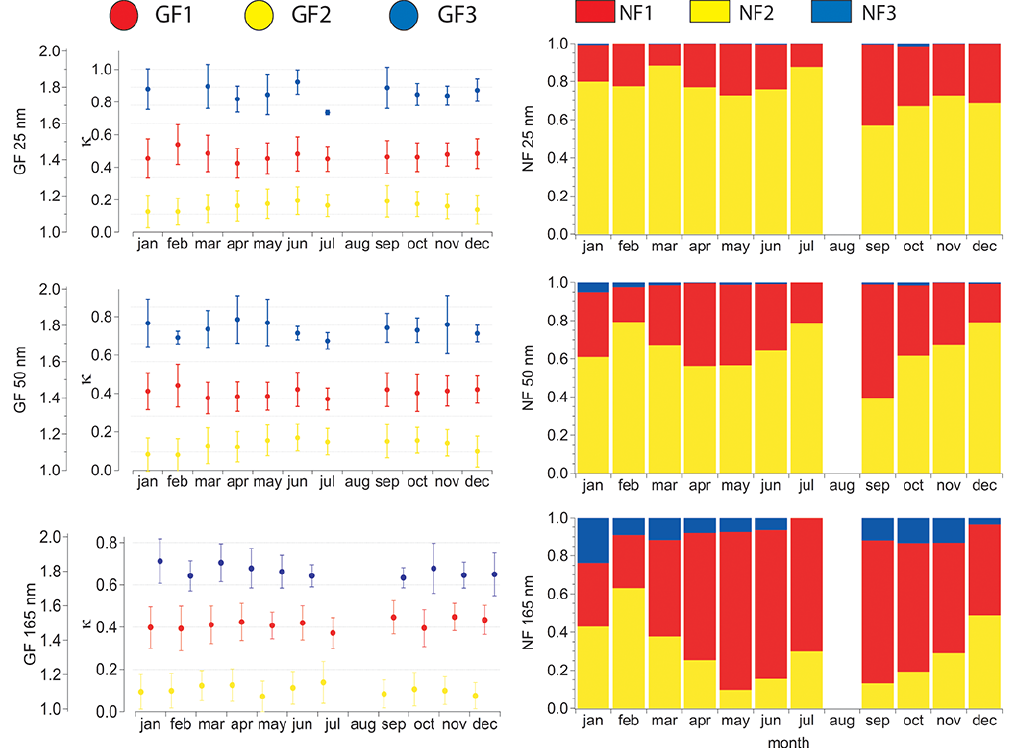
Figure 5. Annual variation of hygroscopic growth factor (GF), kappa value ( κ) (left panels) and number fractions (NF) (right panels) measured at RH90 for particles in the nucleation mode (top panels), Aitken mode (middle panels) and accumulation mode (bottom panels). The coloured bars show the average NF of each hygroscopic mode and the markers give the average GF in each mode, including standard